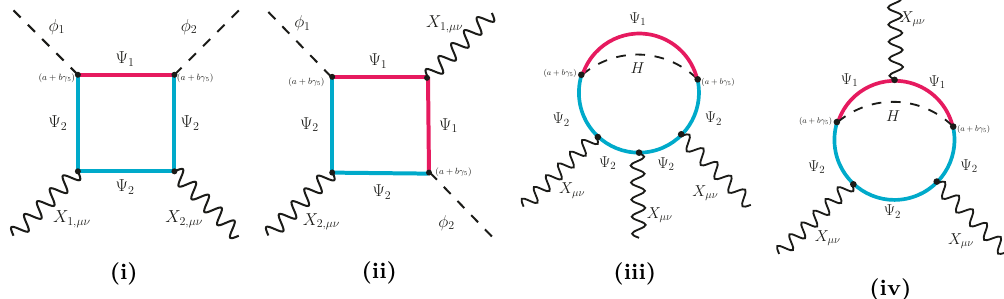
Figure 2. Unfolding SMEFT operators of mass dimension-6 belonging to (i), (ii) the φ 2 X 2 class into one-loop and (iii), (iv) the X 3 class into two-loop Feynman diagrams involving heavy fermion propagators. In order to be concise in our discussion, we have only considered a general Yukawa vertex with the coupling parametrised as a + b γ 5